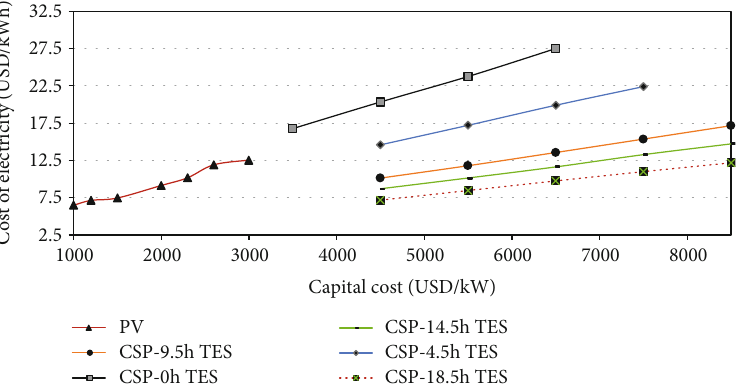
Figure 13: Capital cost (USD/kW) of PV and PT-CSP systems.